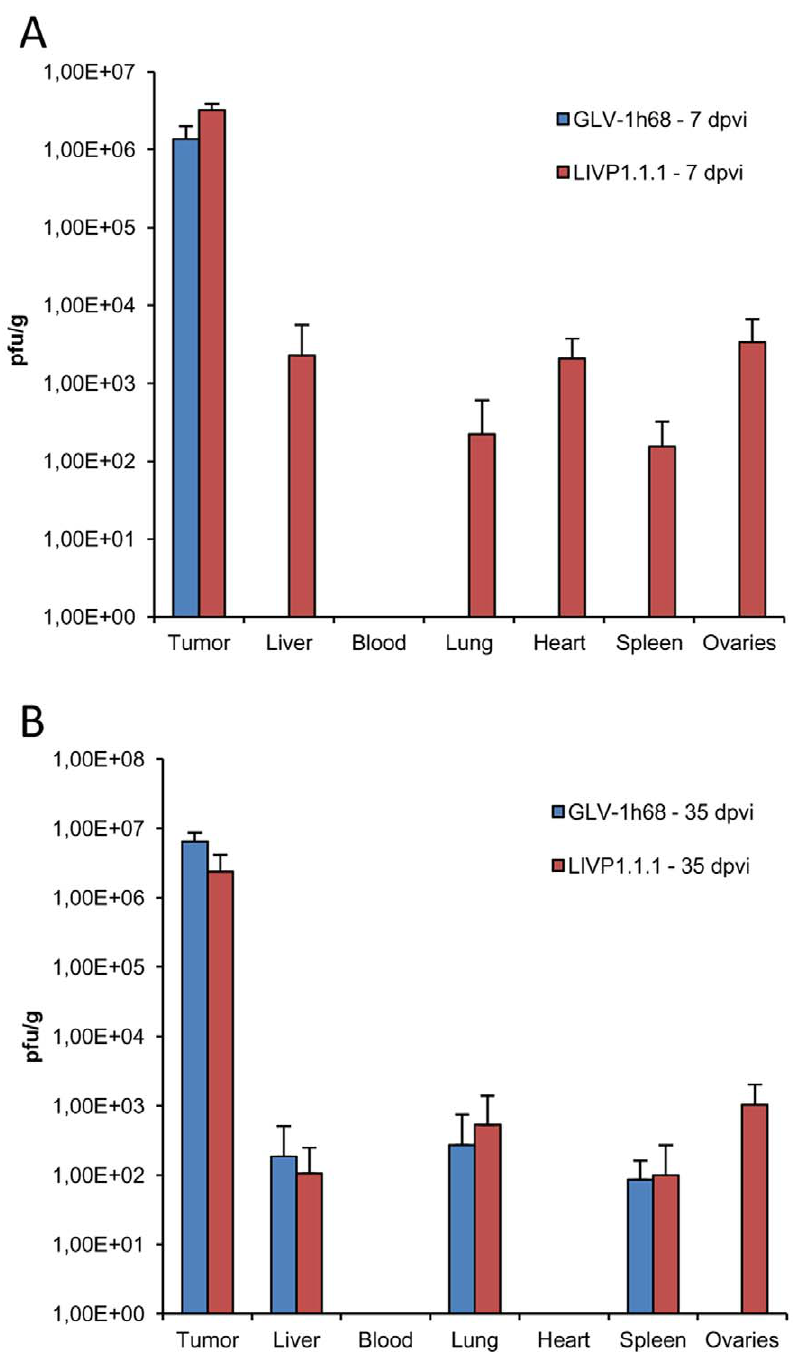
Figure 6. Virus distribution in STSA-1 xenografts after 7 (A) and 35 (B) day post injection with GLV -1h68 or LIVP1.1.1. Tumor-bearing mice were injected with 1 6 10 7 pfu of GLV-1h68 or LIVP1.1.1. Three mice of each group were analyzed at 7 and 35 dpvi for virus distribution. The data were determined by standard plaque assays on CV-1 cells using aliquots of the homogenized tissue and were displayed as mean pfu/g organ or tissue (n=3). For each organ, aliquots of 0.1 ml were measured in triplicates (detection limit: 10 pfu/organ or tissue). The values are the mean of triplicate samples, and the bars indicate SD. Statistical analysis for the tumors was performed using 1-way ANOVA followed by Bonferroni post-test on log transformed pfu data. There were no significant differences between groups (P . 0.05). The study was repeated in two independent experiments.